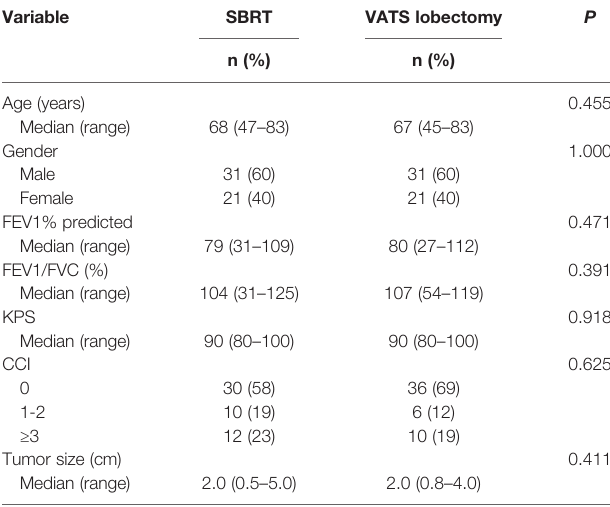
TABLE 2 | Characteristics of propensity score-matched patients.